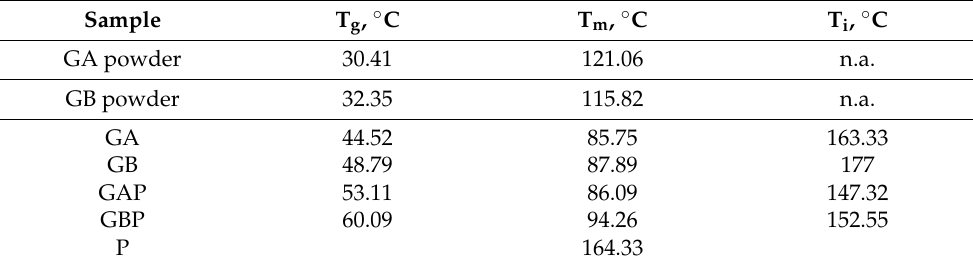
Table 2. Temperatures from DSC analysis.